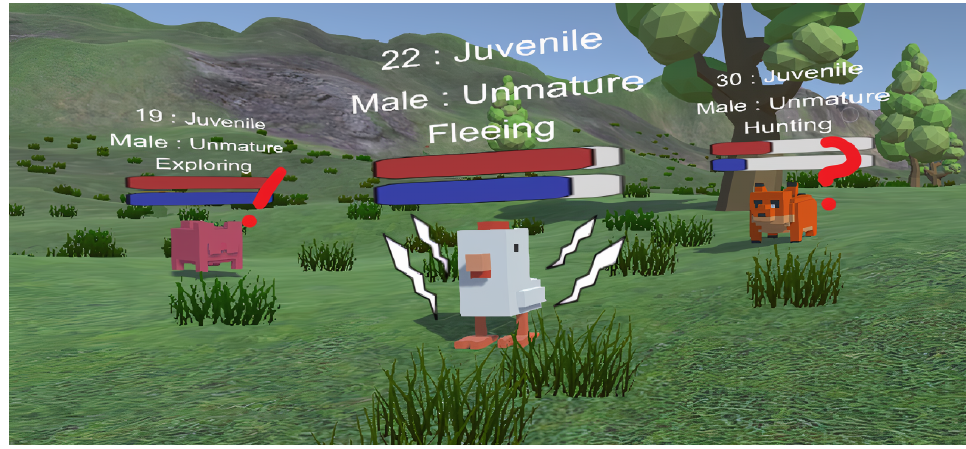
Figure 11. Animals with a higher speed can outrun any dangerous situations.